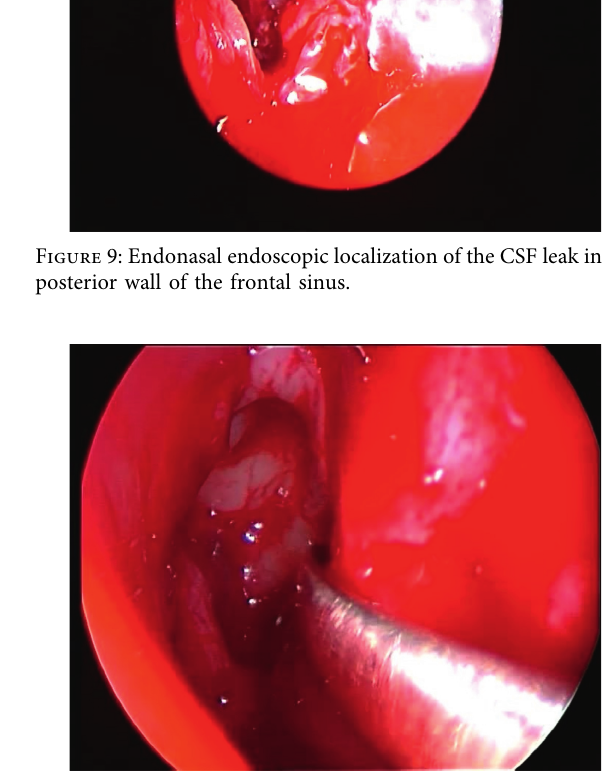
Figure 10: Endoscopic view showing the onlay free graft closure.